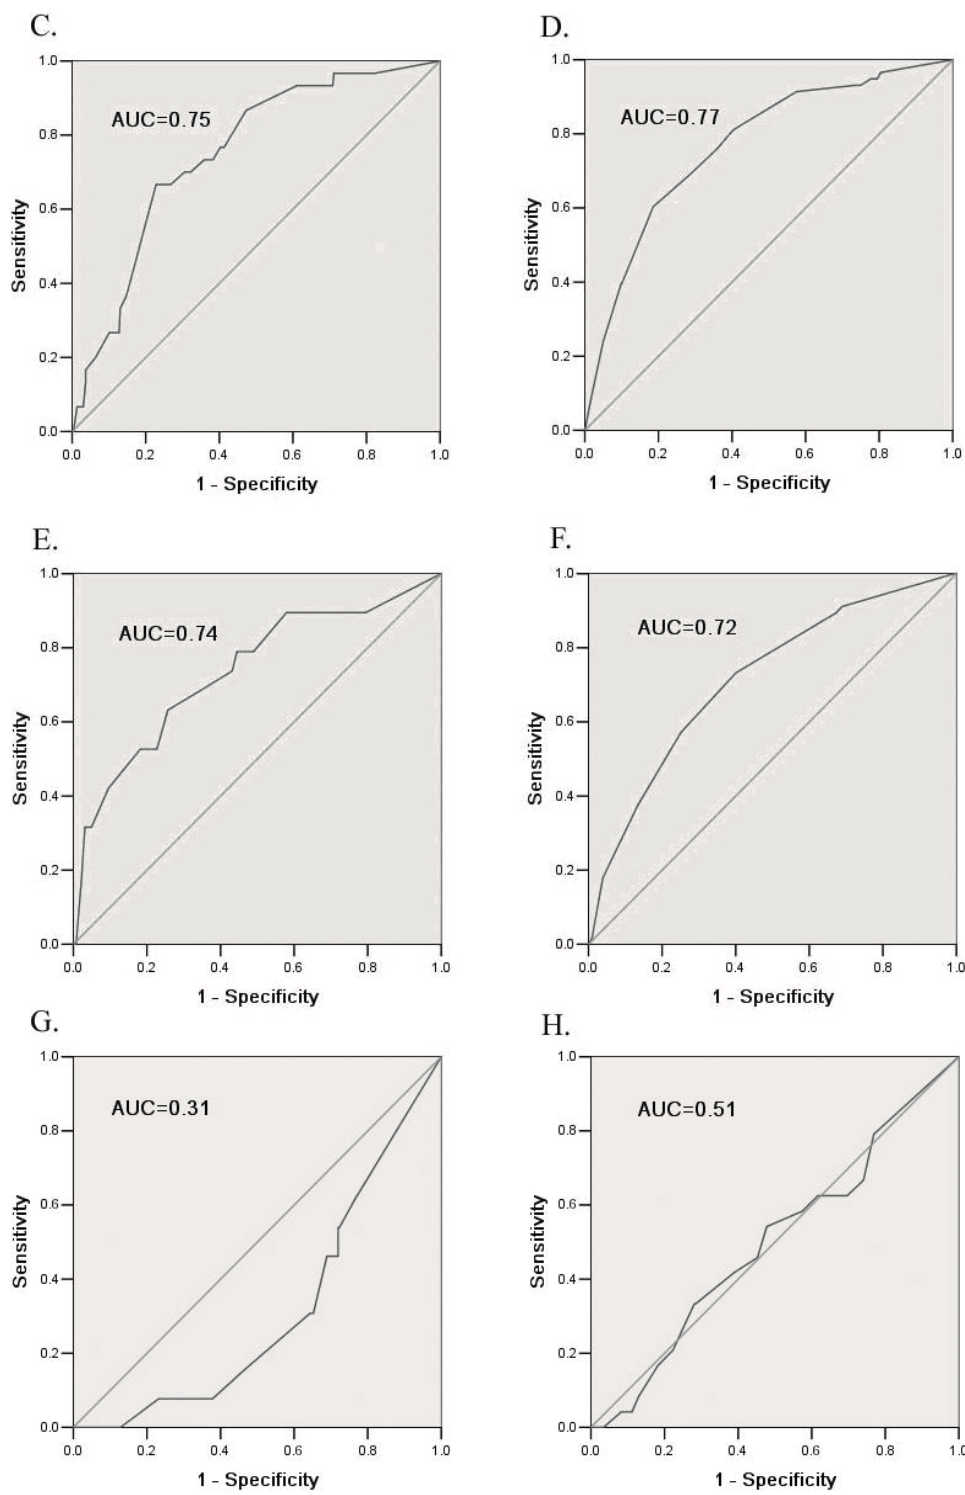
Figure 1. ROC curves of the risk scores for detecting IFG. ( A ). ROC curve for men in the derivation sample; ( B ). ROC curve for women in the derivation sample; ( C ). ROC curve for men in the validation sample 1; ( D ). ROC curve for women in the validation sample 1; ( E ). ROC curve for men in the validation sample 2; ( F ). ROC curve for women in the validation sample 2; ( G ). ROC curve for men in the validation sample 3; ( H ). ROC curve for women in the validation sample